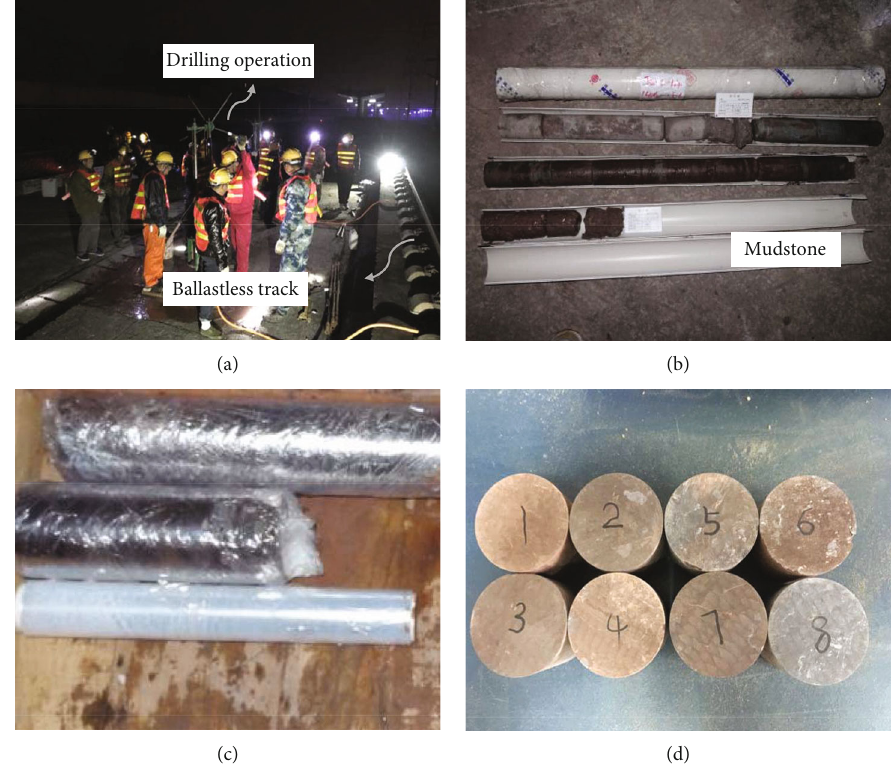
Figure 3: The whole process of sampling in the swelling test: (a) drilling on site; (b) drilled core; (c) sealing of core; (d) preparation of cylindrical